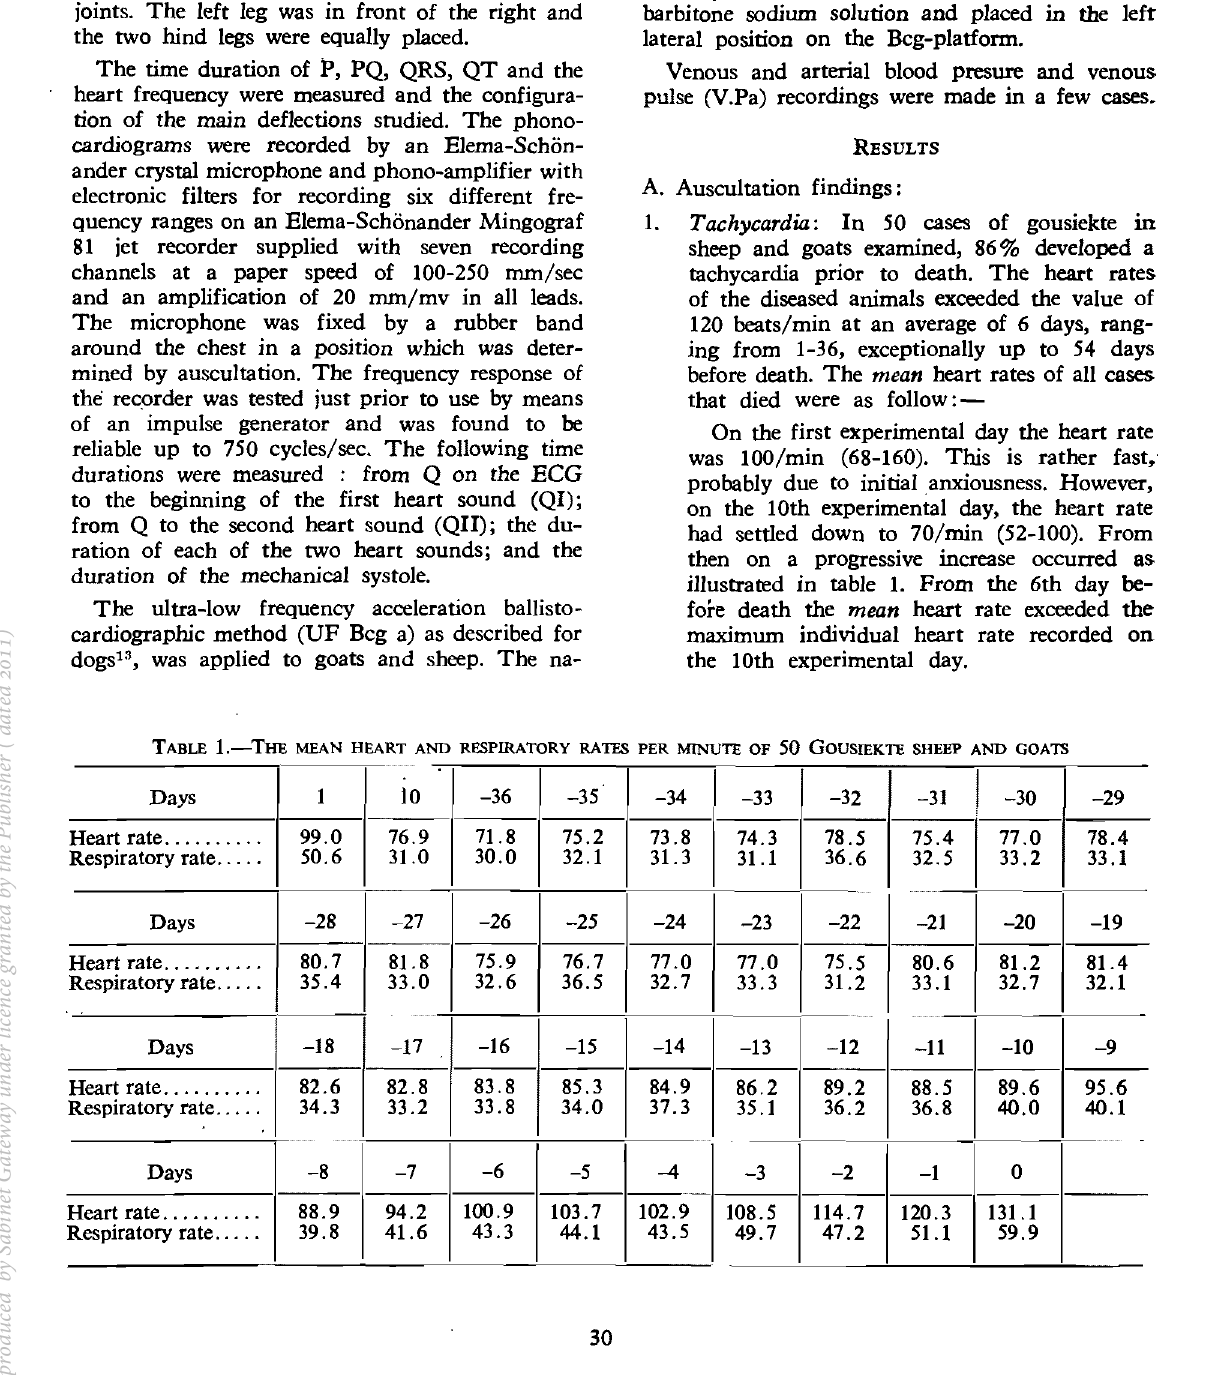
TABLE I.-THE MEAN HEART AND RESPIRATORY RATES PER MINUTE OF 50 GOUSrEKTE SHEEP AND GOATS